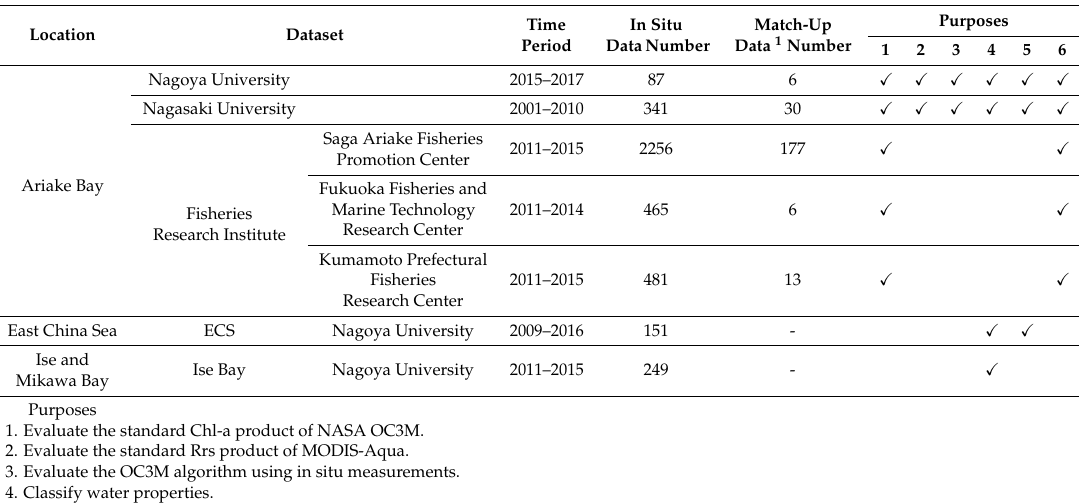
Table 1. Summary of in situ datasets. Chl-a: chlorophyll-a concentration, OC3M: standard MODIS Chl-a algorithm, Rrs: remote sensing